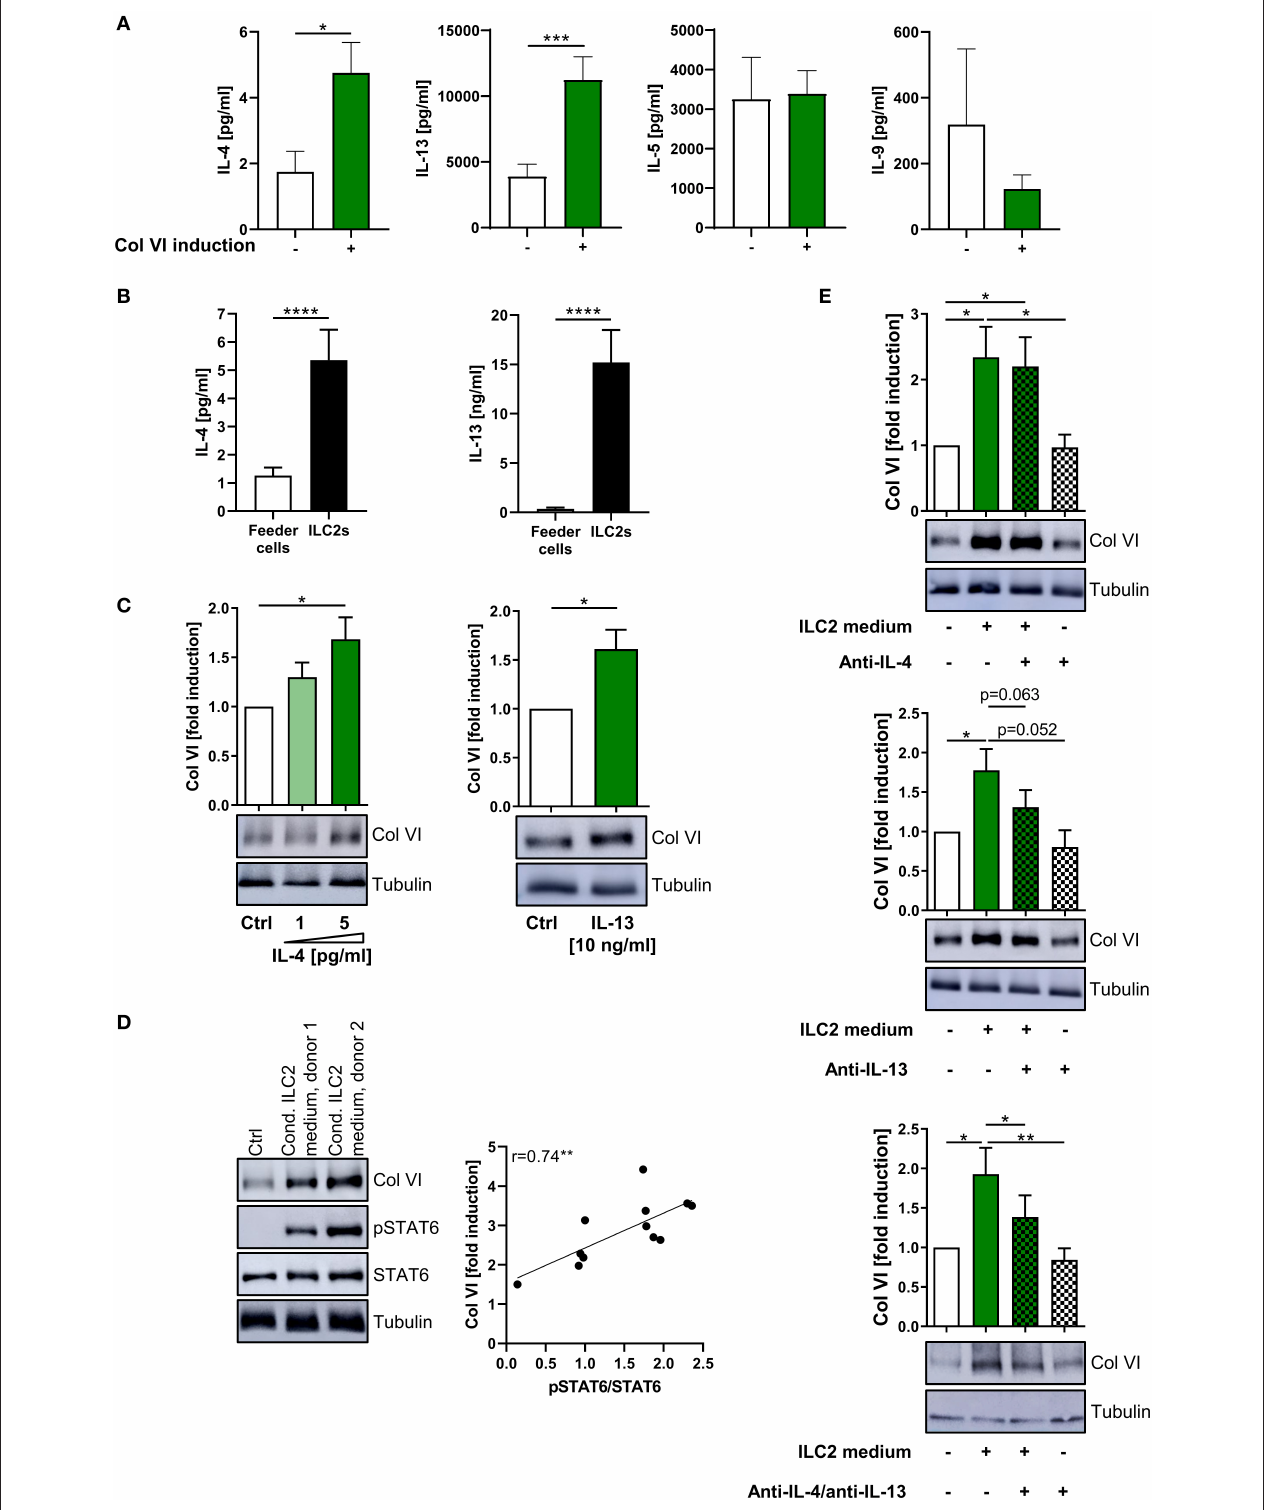
FIGURE 6 | Additive effect of ILC2-derived IL-4 and IL-13 on pulmonary Col VI induction. (A) ILC2 conditioned supernatants were grouped according to their potency to induce Col VI expression in human lung fibroblasts (based on Western blot analyses) and were analyzed for concentrations of IL-4 ( n = 5–32), IL-13 ( n = 6–30), IL-5